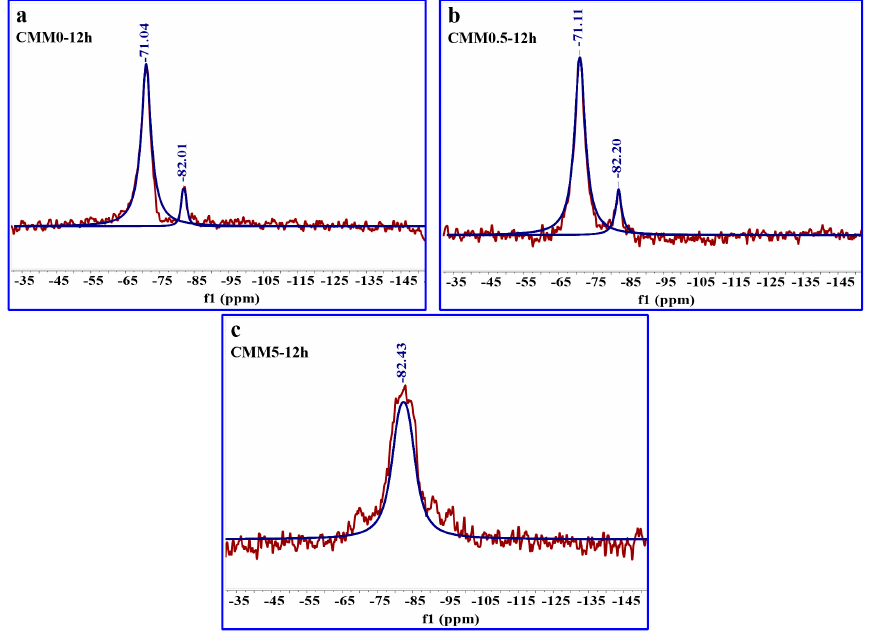
Figure 15. 29 Si NMR spectra of ( a ) CMM0, ( b ) CMM0.5 and ( c ) CMM5 samples autoclaved for 12 h. Table 5. The RBO values of CMM0, CMM0.5 and CMM5 samples autoclaved for 12 h. Sample